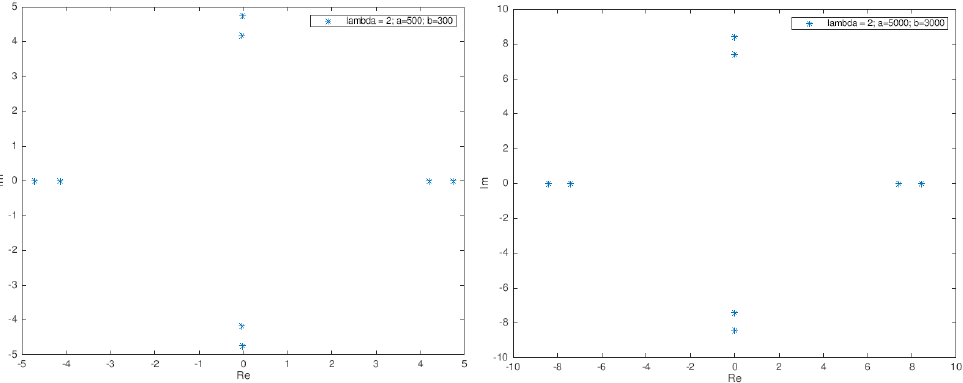
Figure 10. Homotopy graph for λ = 2 and different values for a , b . Note that the complex conjugate eigenvalues converge to the imaginary axis.